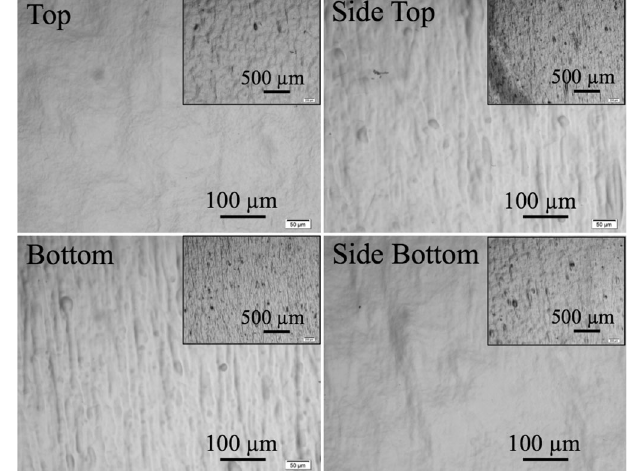
FIG. 12. Optical microscope images of the Nb samples after lab EP-1. Insets show zoomed-out images.